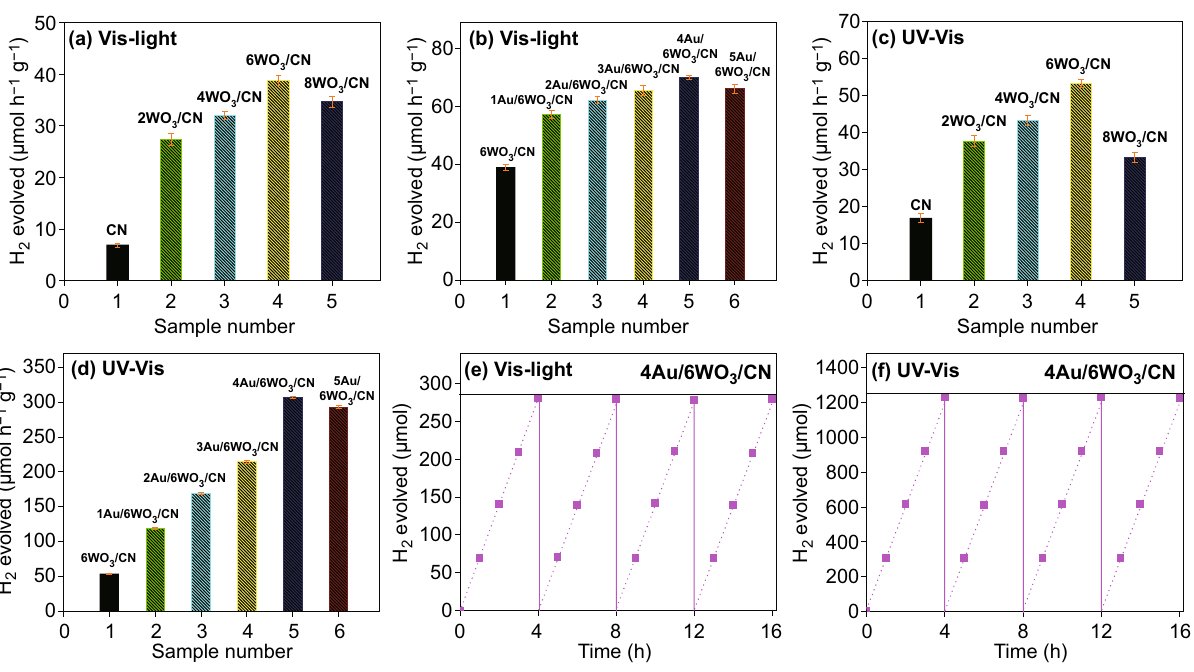
Fig. 6 H 2 production activity of a CN and x WO 3 /CN photocatalysts under visible light, b 6WO 3 /CN and y Au/6WO 3 /CN photocatalysts under visible light, c CN and x WO 3 /CN photocatalysts under UV–visible light, and d 6WO 3 /CN and y Au/6WO 3 /CN photocatalysts under UV–visible light. Error bars are added to Fig. 6 a – d . Photocatalytic stability and recyclability test of the 4Au/6WO 3 /CN composite for H 2 production e under visible light and f under UV–visible